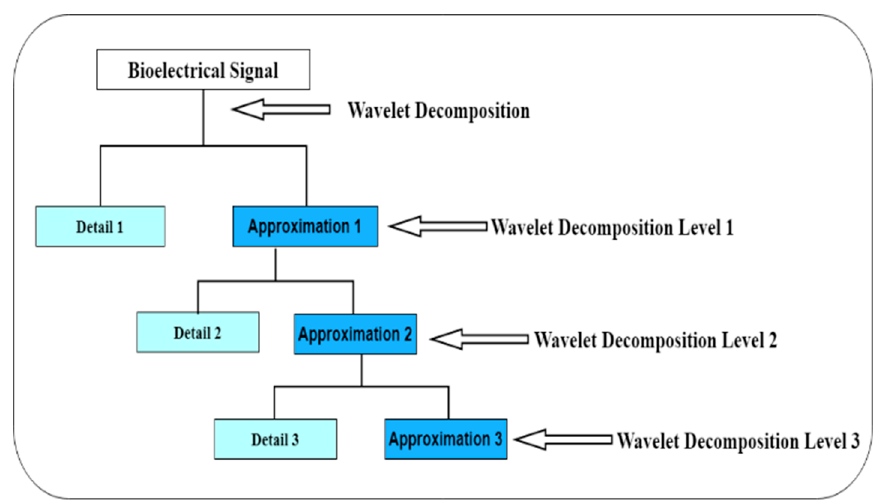
Figure 5. Wavelets decomposition of the detail and approximation coefficient.